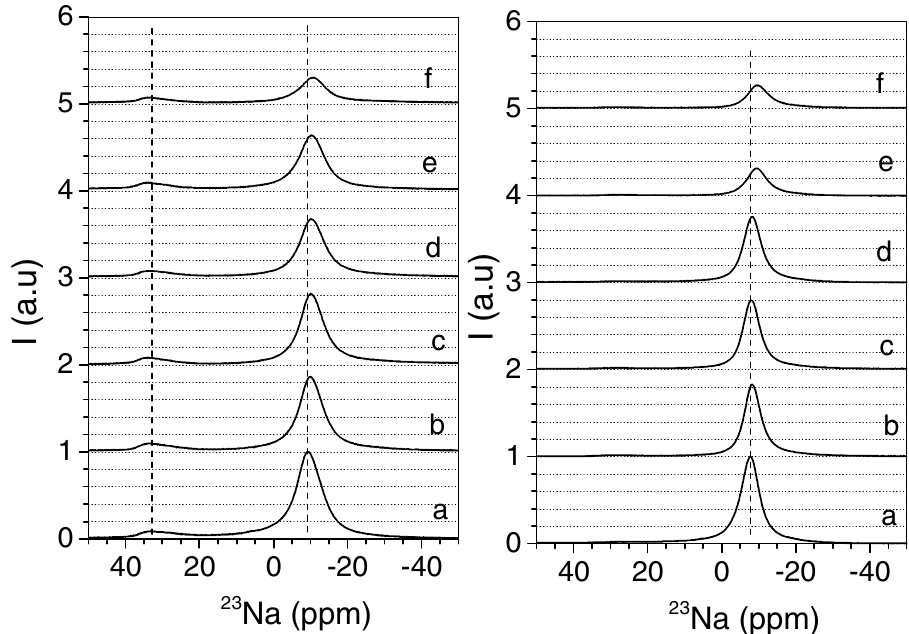
Figure 3. 23 Na MAS NMR spectra of Mica-2 (n = 2), left graph, and, Mica-4 (n = 4), right graph. ( a ) NaM n , ( b ) Ch-NaM n -A, ( c ) Ch-NaM n -B, ( d ) Ch-NaM n -C, ( e ) Ch-NaM n -D, and, ( f ) Ch-NaM n -E.